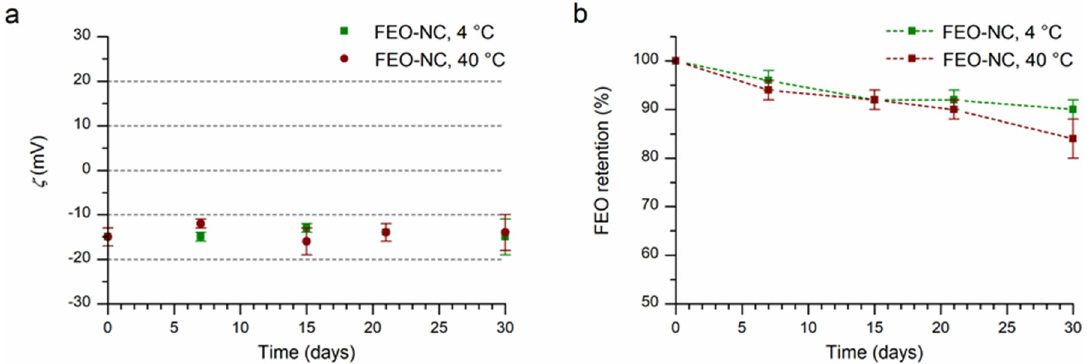
Figure 3. Zeta potential ( a ) and FEO retention ( b ) of FEO-NCs over time (storage at 4 and 40 °C). The weakly acidic pH (5.7 ± 0.1) measured for the nanocapsule suspension is at- tributable to terminal residues of carboxyl groups of the PCL